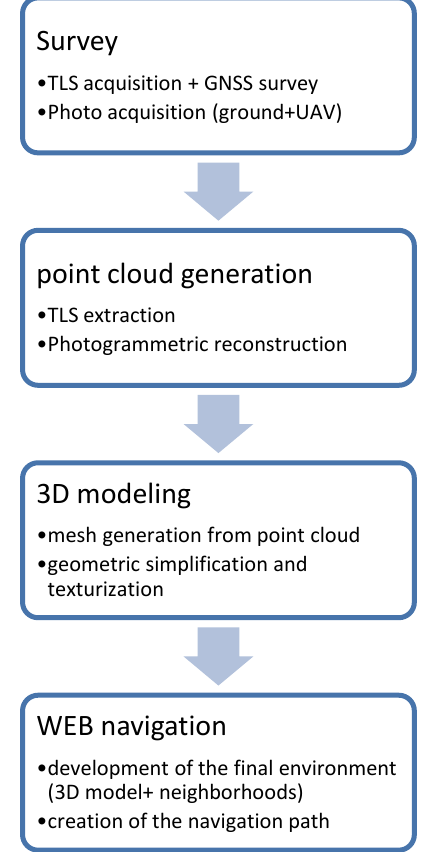
Figure 2. The main